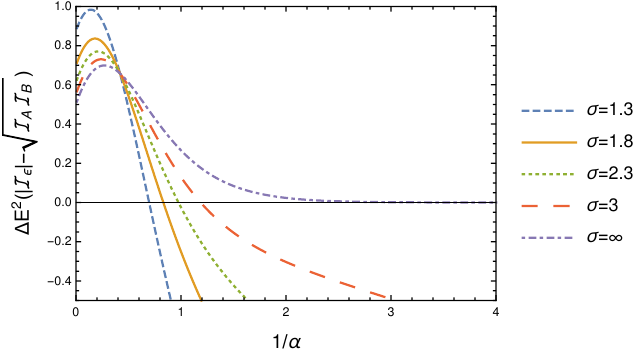
√ (cid:0) (cid:1) is plotted for two anti-parallelly |I ε | − I A I B